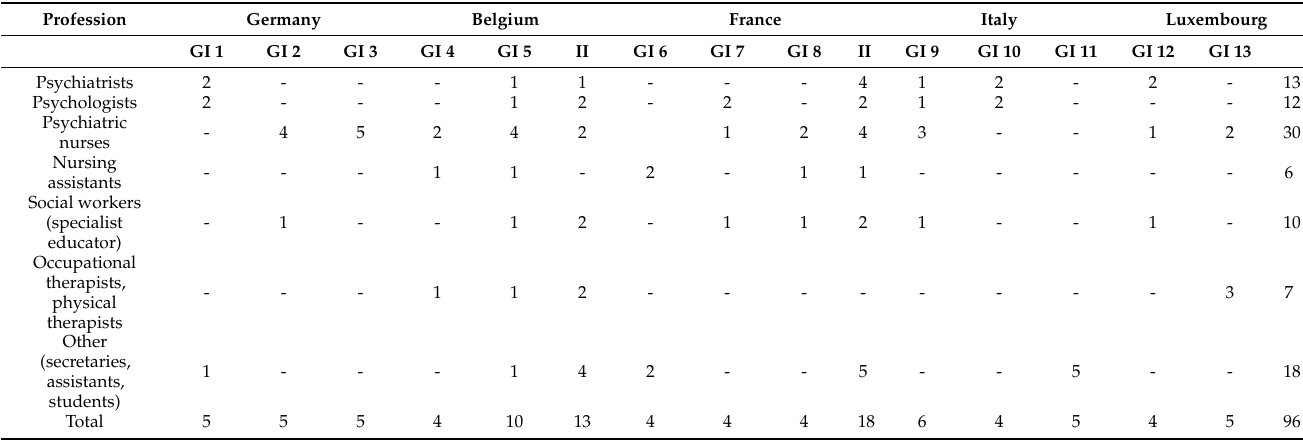
Table 1. Distribution of group and individual interview participants according to profession in psychiatric